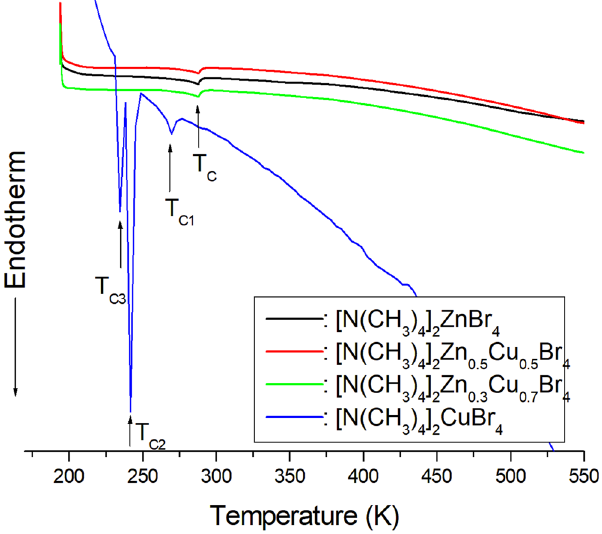
Figure 3. Differential scanning calorimetry (DSC) thermogram of [N(CH 3 ) 4 ] 2 Zn 1- x Cu x Br 4 ( x = 0, 0.5, 0.7, and 1) single